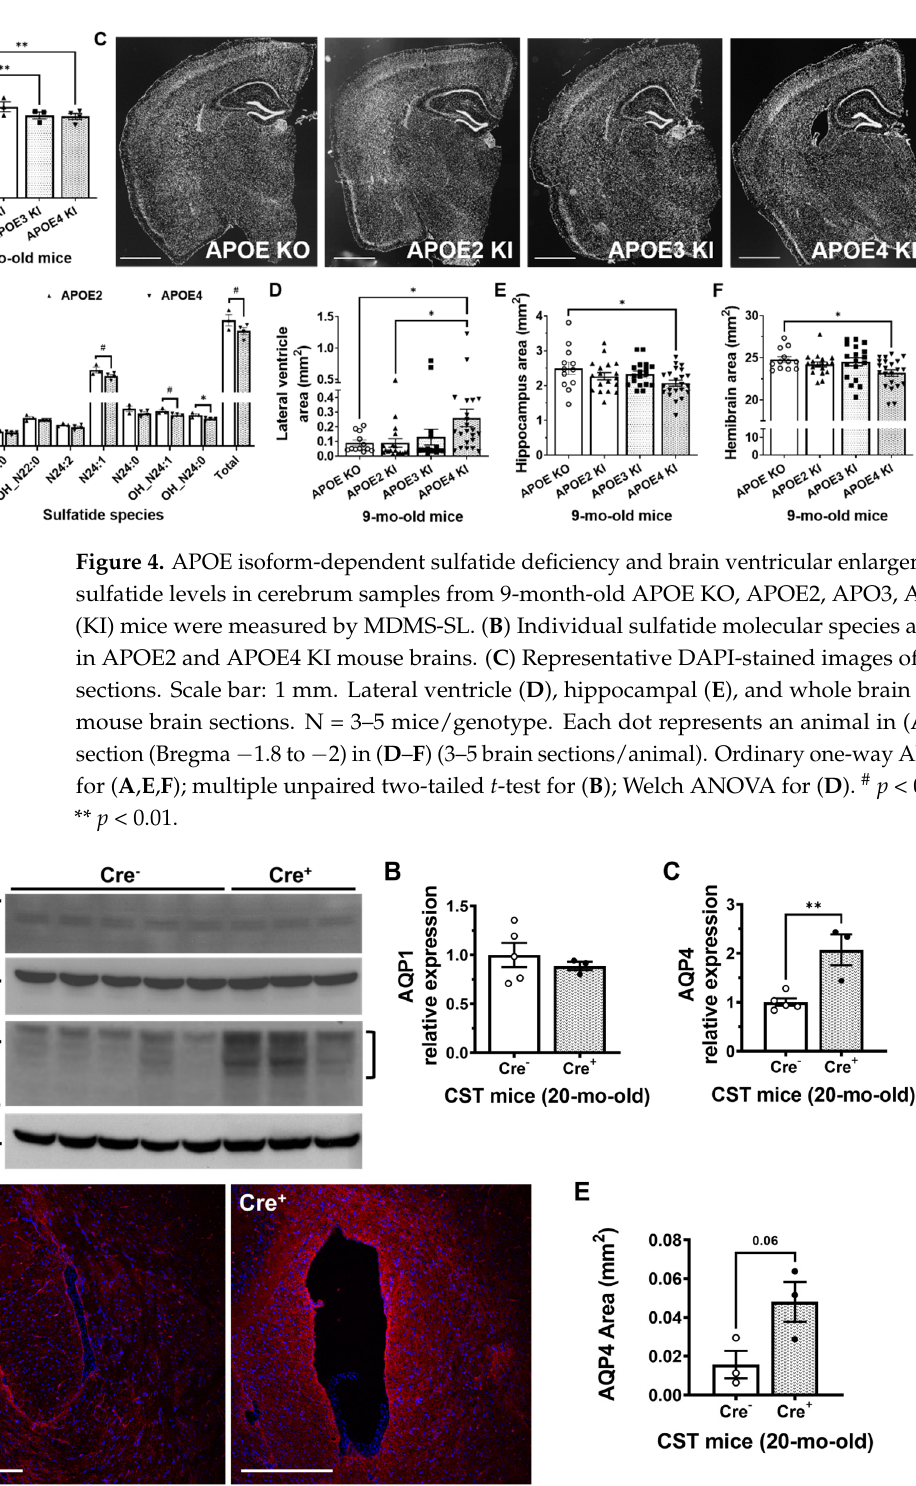
Figure 5. Aquaporin levels in the sulfatide deficient mouse brain. ( A ) Expression of AQP1 and AQP4 in Cre + and Cre − cerebrum samples were measured by Western Blot and quantified ( B , C ). Multiple AQP4 bands with different levels of glycosylation were observed (bracket). ( D ) Representative immunofluorescence image for AQP4 (red) in the CST cKO mouse brain at 20 months of age. Scale bar: 250 μ m. ( E ) AQP4 immunofluorescent area around the lateral ventricle was quantified using Image J. Unpaired two ‐ tailed t ‐ test (normality and equal variance were assumed/confirmed). ** p < 0.01.